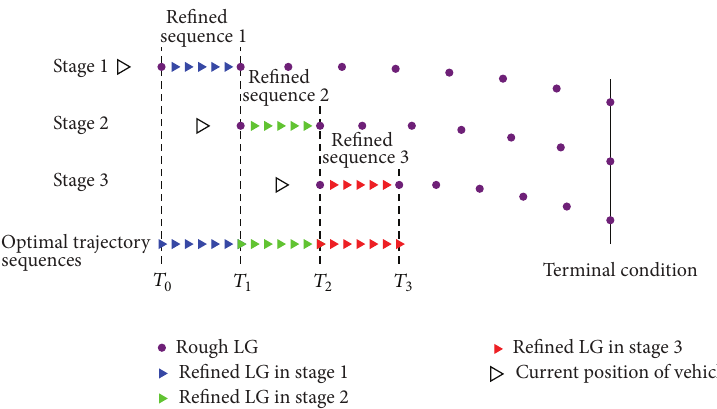
Figure 2: Illustration of the main idea of the multistage trajectory control